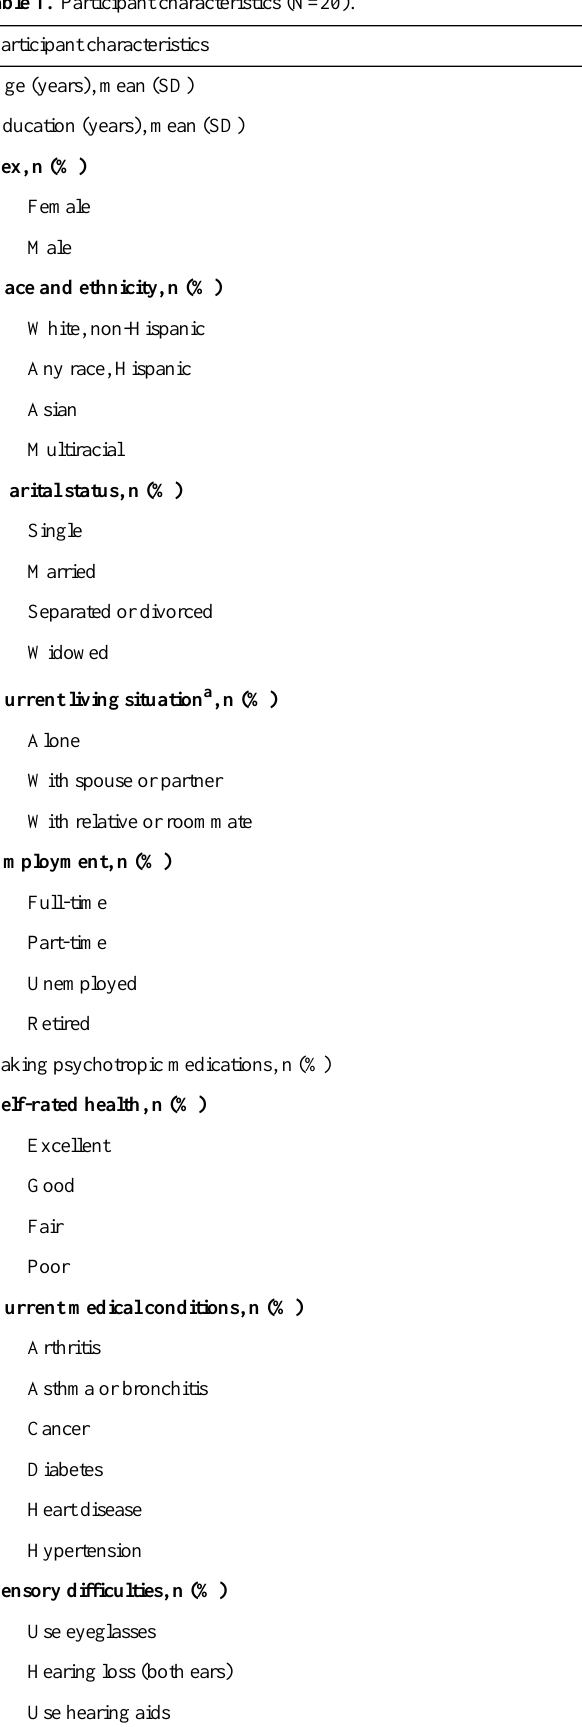
Table 1. Participant characteristics